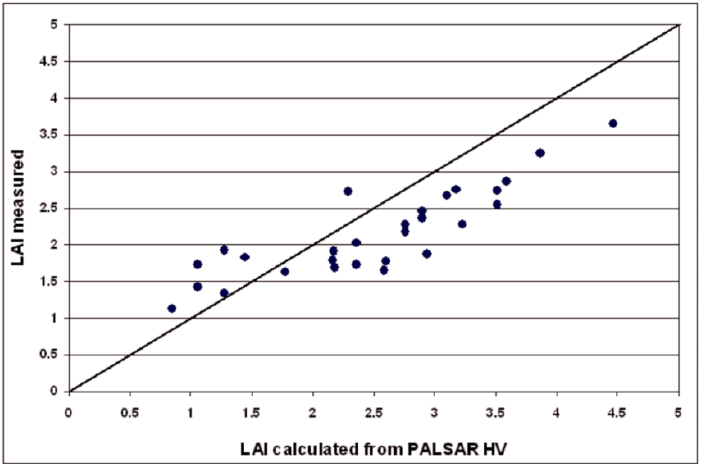
Figure 9. Plot of the LAI measured versus estimated from PALSAR HV images.